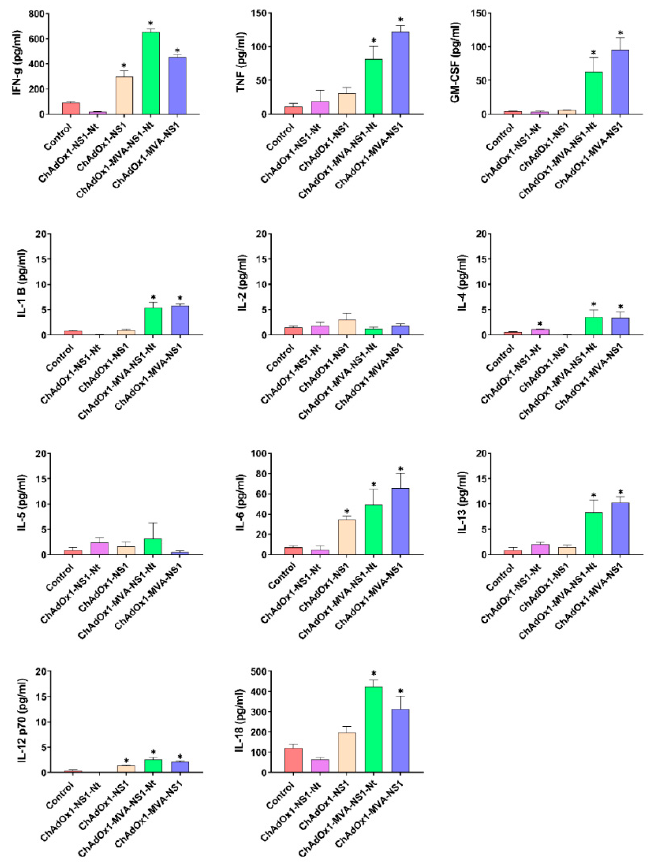
Figure 6. Cytokine production measured in supernatants from mice splenocytes two weeks post-immunization (prime-only) or after boosting with MVAs. Prior to quantification, splenocytes from immunized and non-immunized mice were stimulated for 72 h with 10 µg/mL of NS1-152 peptide or left untreated. Values of non-stimulated samples were subtracted from values of stimulated samples. Bars represent mean values of each group and error bars represent SEM. Asterisks denote significant di ff erences between stimulated splenocytes of immunized and non-immunized control mice (* p < 0.05) (The Mann–Whitney U test).